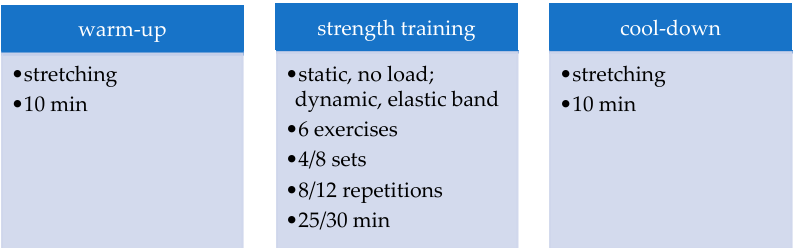
Figure 2. Description of the home based training sessions.